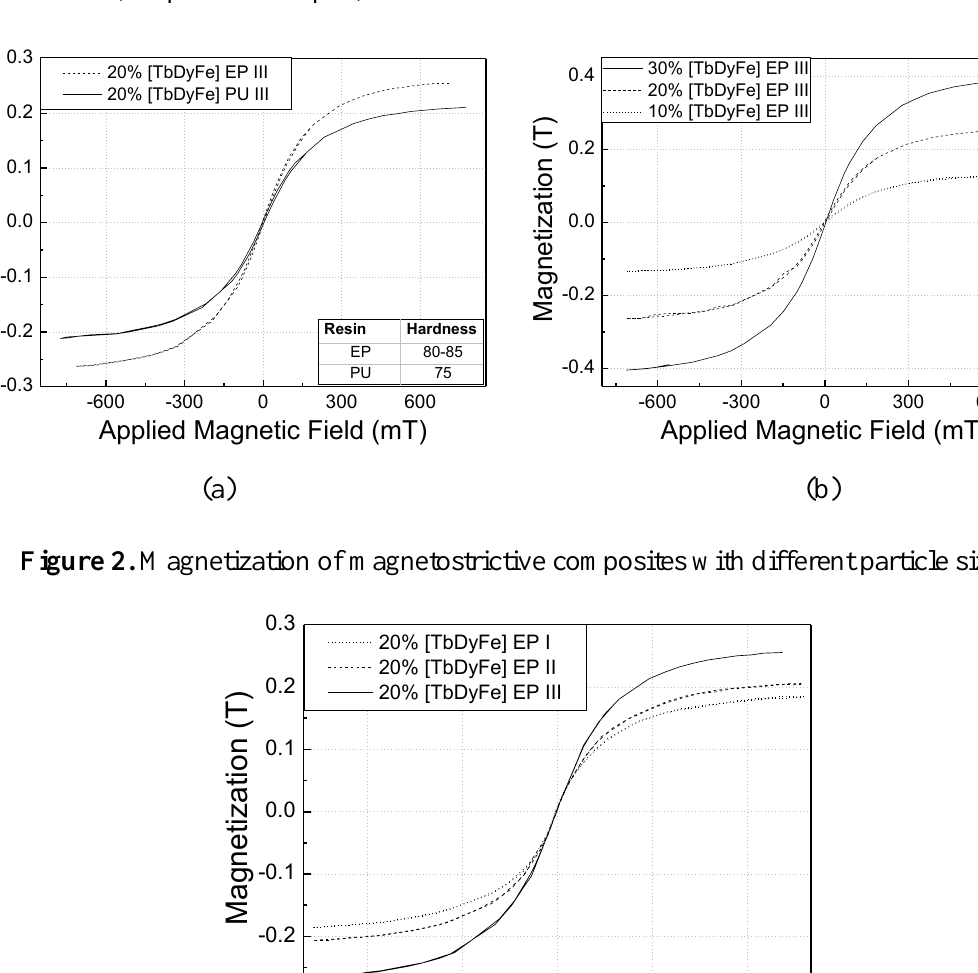
Figure 1. Magnetization vs . applied magnetic field for: (a) different binding resins (comparison between samples in Groups A and B); and (b) different volume fractions of Terfenol-D (samples in Group C).